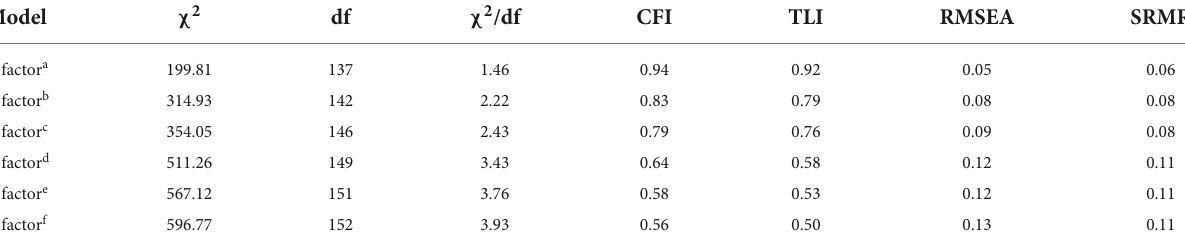
TABLE 1 Results of confirmatory factor